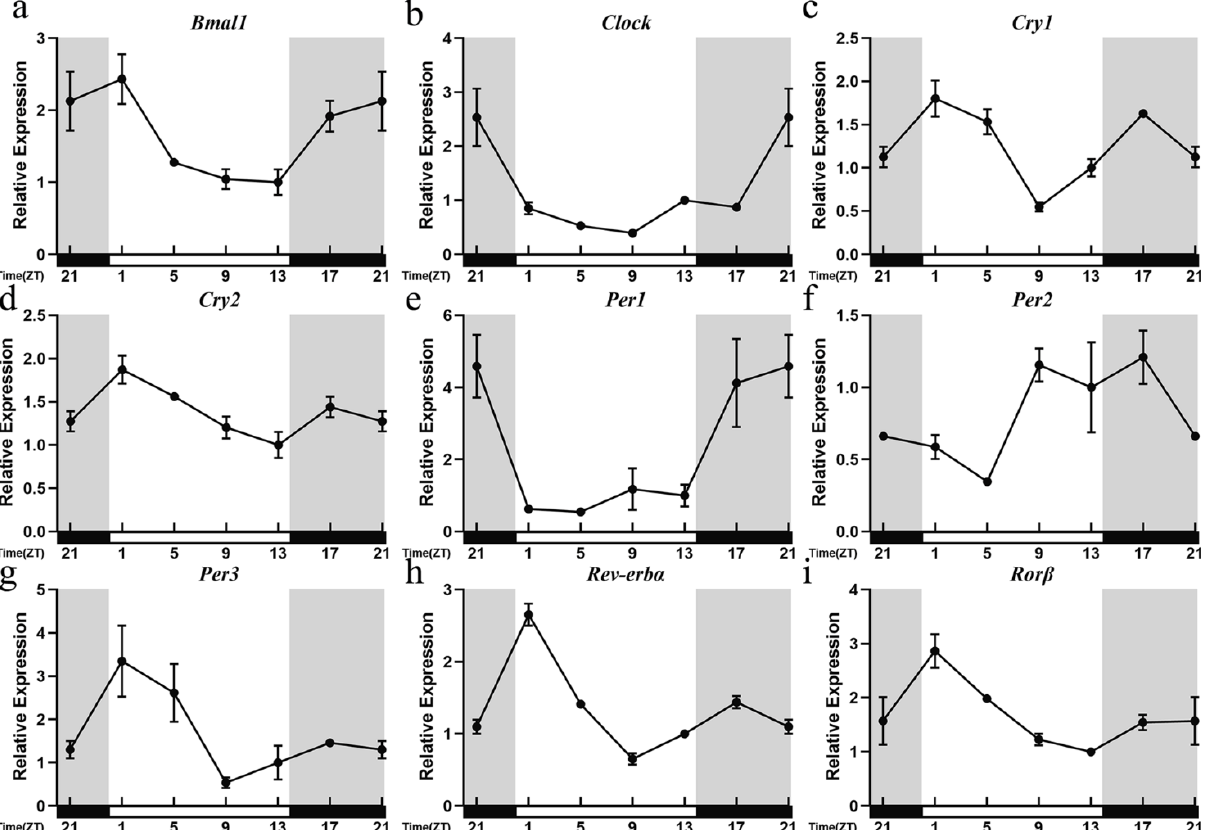
Figure 1. Temporal patterns of the mRNA levels of nine clock genes in the hypothalamus of mice in CON group. ( a ) Bmal1 , ( b ) Clock , ( c ) Cry1 , ( d ) Cry2 , ( e ) Per1 , ( f ) Per2 , ( g ) Per3 , ( h ) Rev-erbα , ( i ) Rorβ . The horizontal white bar on each figure represents the subjective daytime, and the black bar represents the subjective night. The relative mRNA levels were normalized to Gapdh and presented as the fold of ZT13; n = 3 mice per time point. Quantitative analysis of the PCR data is shown as the mean ± SEM. One-way ANOVA was used to evaluate the significance of differences among the six time points of the daily profile.